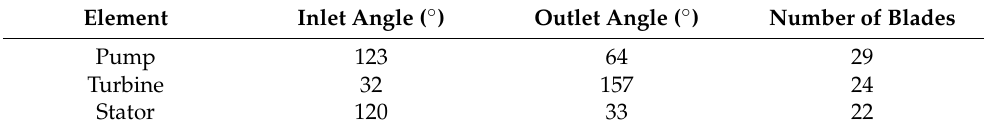
Table 1. Structural parameters of HTC. Element Inlet Angle ( ◦ ) Outlet Angle ( ◦ ) Pump 123 Turbine